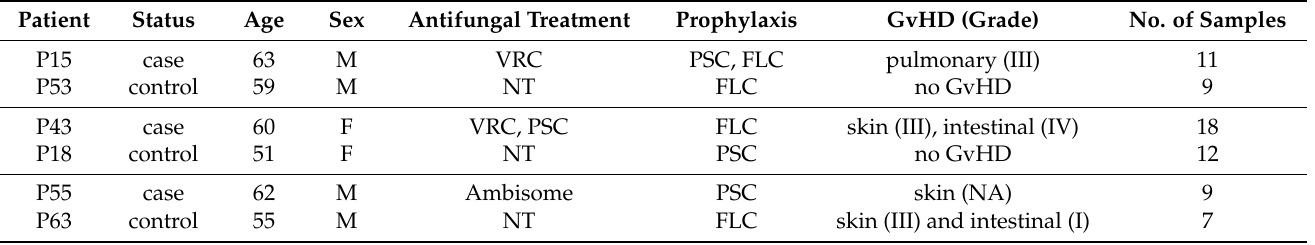
Table 1. Clinical information of profiled IPA cases and their matched controls (original co- hort,